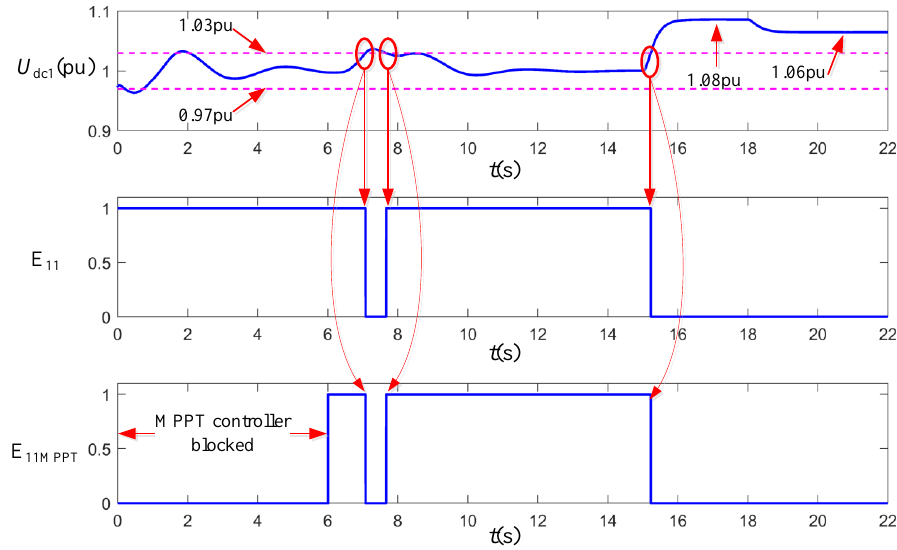
Figure 15. Primary side DC voltage and enable signal of original voltage loop and MPPT controller in boost converter 11.